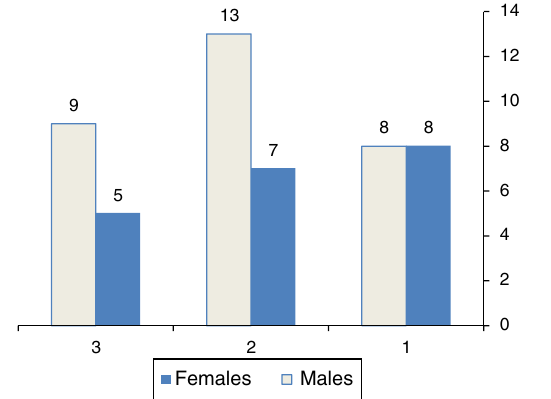
Figure 1 Sex of patients among three groups, G1 (perforation size > 50% of TM area), G2 (perforation size between 25% and 50% of TM area), G3 (perforation size ≤ 25% of TM area).